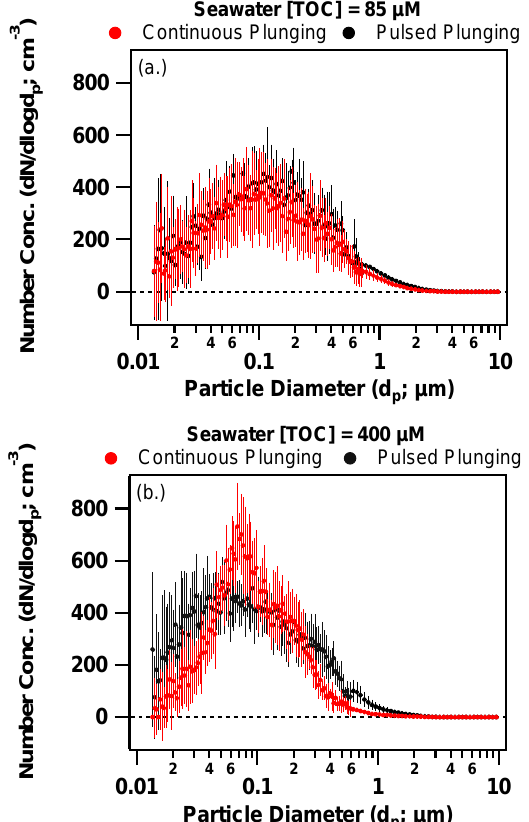
Figure 7. Number size distributions for MART-generated SSA par- ticles using continuous (red) and pulsed (black) plunging-waterfall modes ( ± 1 σ error bars). The change in the shape of the size distri- bution is clearly evident between the continuous and pulsed plung- ing cases when the seawater is enriched with organic matter. Con- centrations of particles with d p >0.3 and d p <0.05 µm are smaller during continuous plunging, indicating a change in the SSA particle production mechanism due to the overproduction of